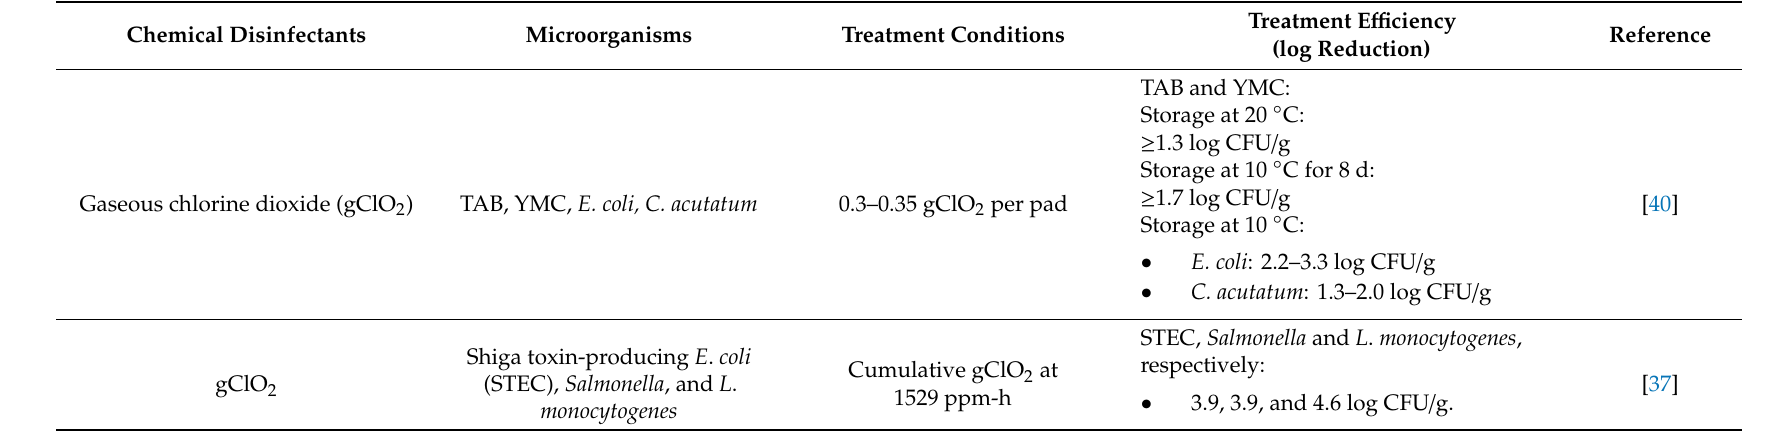
Table A2. Chemical strategies for the control of microorganisms on fresh blueberries.